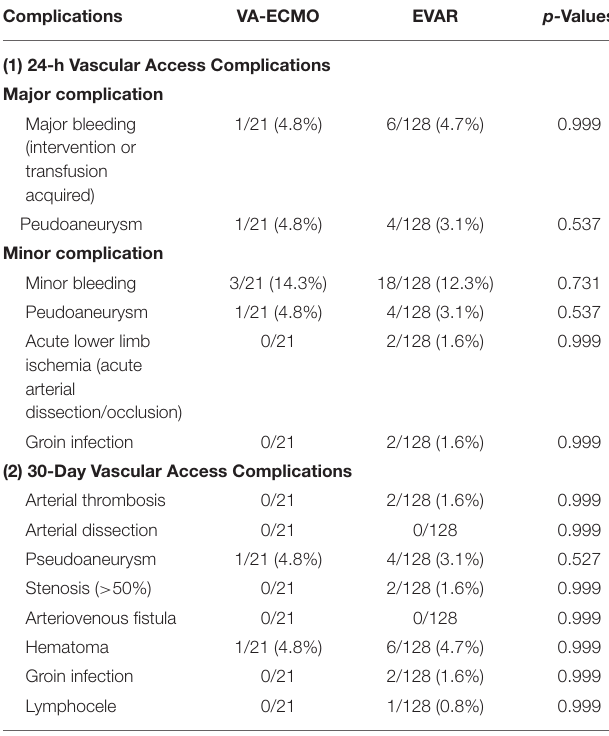
TABLE 1 | Characteristics of patients undergoing VA-ECMO and EVAR. Characteristic